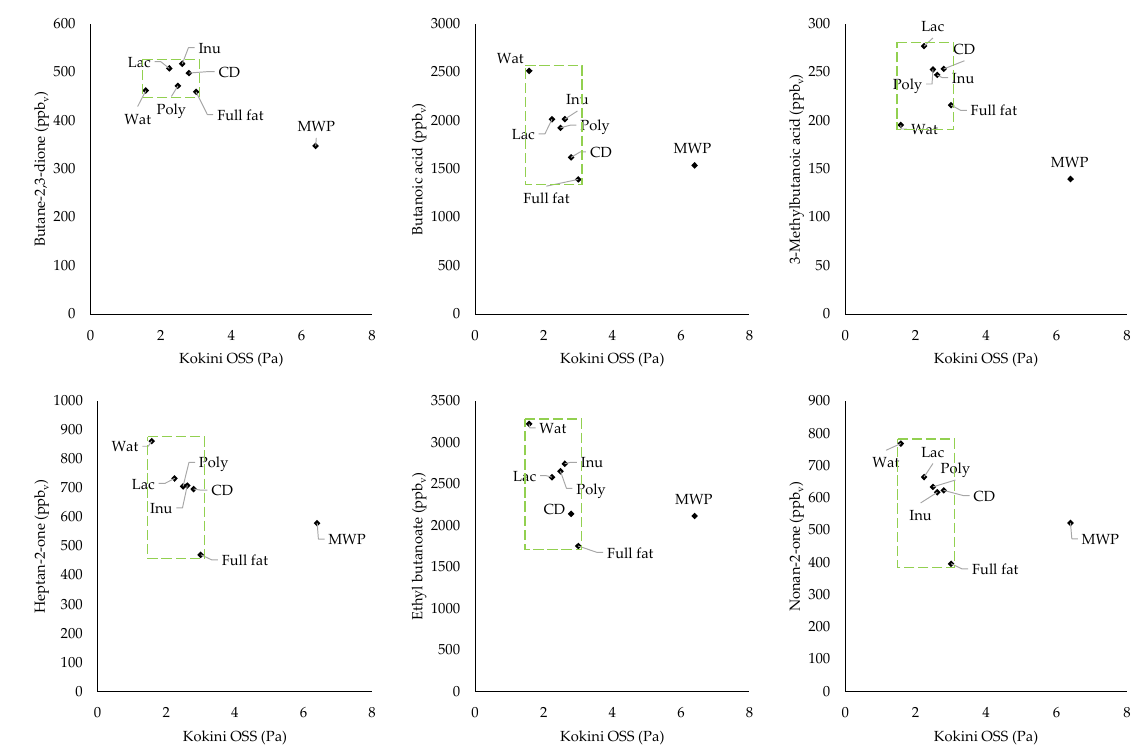
Figure 4. Headspace concentrations of the aroma compounds versus Kokini OSS.